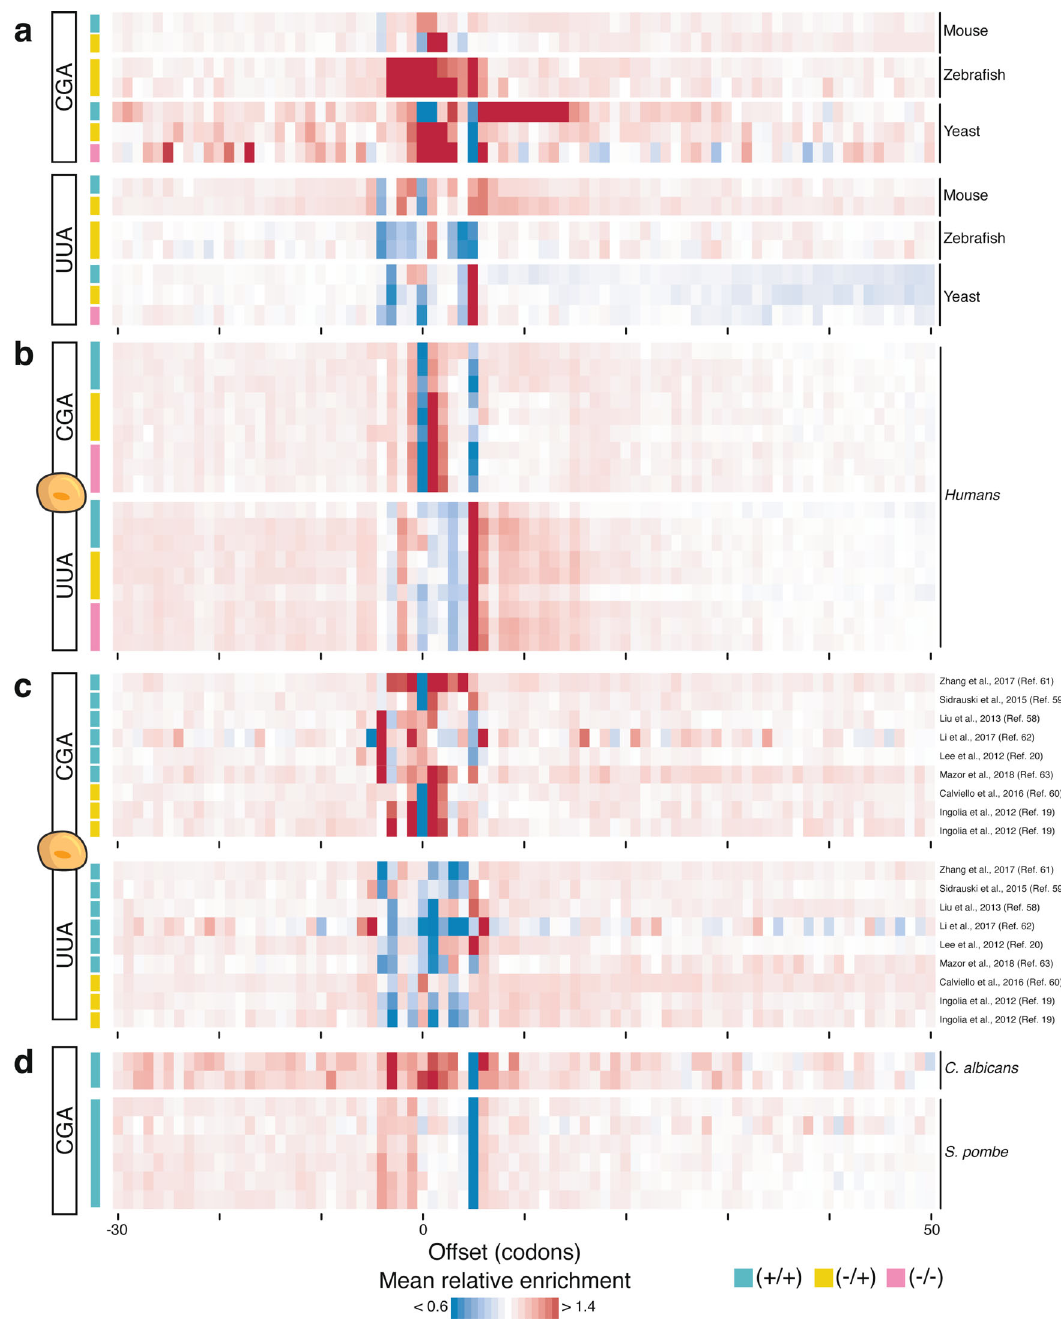
Fig. 4 Cycloheximide (CHX) pre-treatment does not alter ribosome occupancy downstream of rare codons in most species. a Transcriptome-wide ribosome enrichment pro fi les according to Hussmann et al. 33 using libraries generated from E14 mouse embryonic stem cells 5 , zebra fi sh embryos 10 , and wild-type yeast (this study) surrounding CGA and UUA codons and using different CHX treatment regimens. b Same as a for long footprints of HEK 293T cells. c Same as a for published human ribosome pro fi ling datasets 19,20,58 – 63 . d Same as a for the CGA codon in C. albicans and S. pombe (this study). This plot only uses long footprints (28 – 32